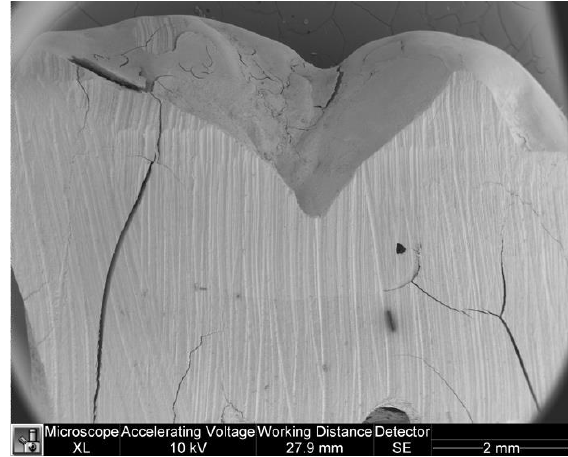
Figure 5. Microleakage in a specimen of study group.